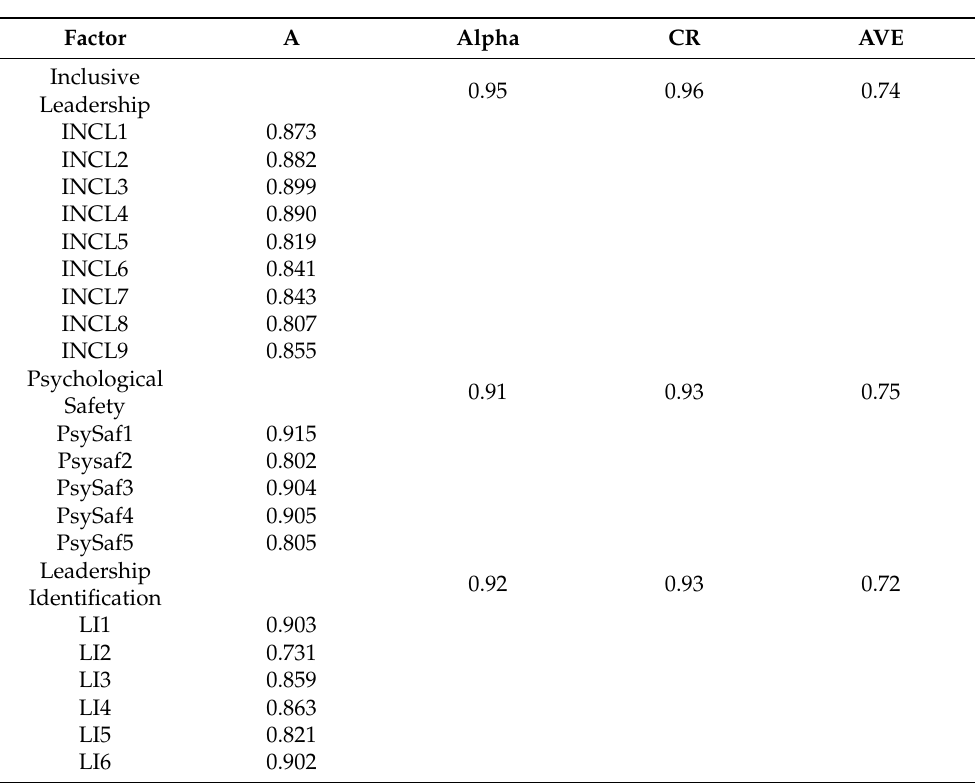
Figure 2. Measurement Model. Table 1. Factor Loading, Alpha, CR, and AVE.